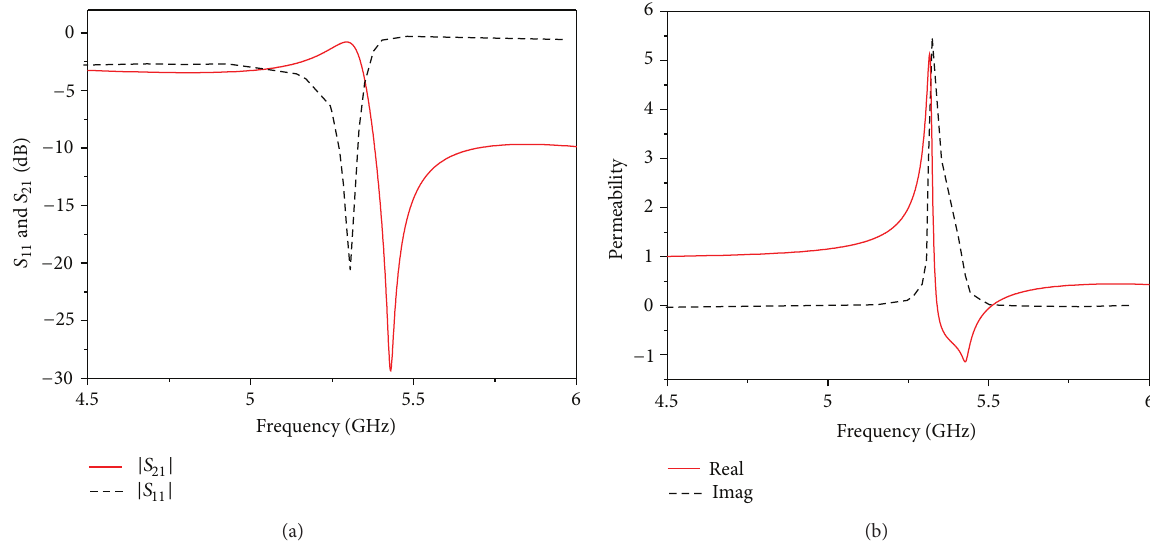
Figure 2: (a) The 𝑆 -parameters of NPM, (b) permeability of